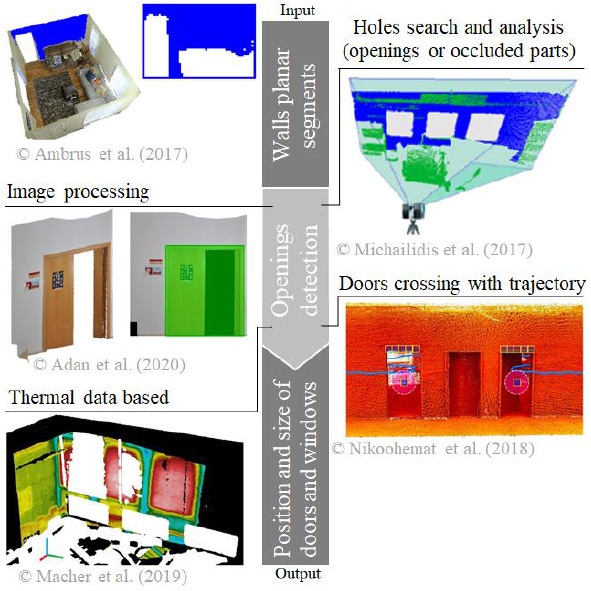
Figure 4. Main methods used for openings